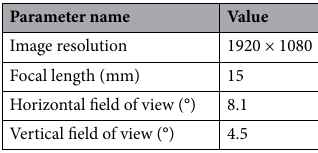
Table 2. The camera system